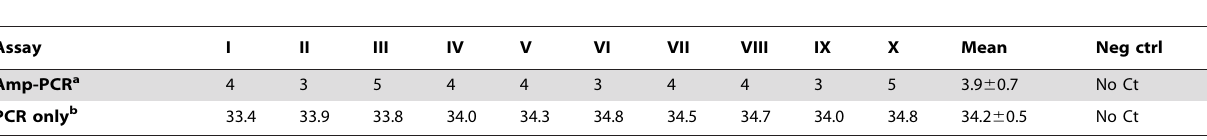
Table 1. Reproducibility of the Amp-PCR